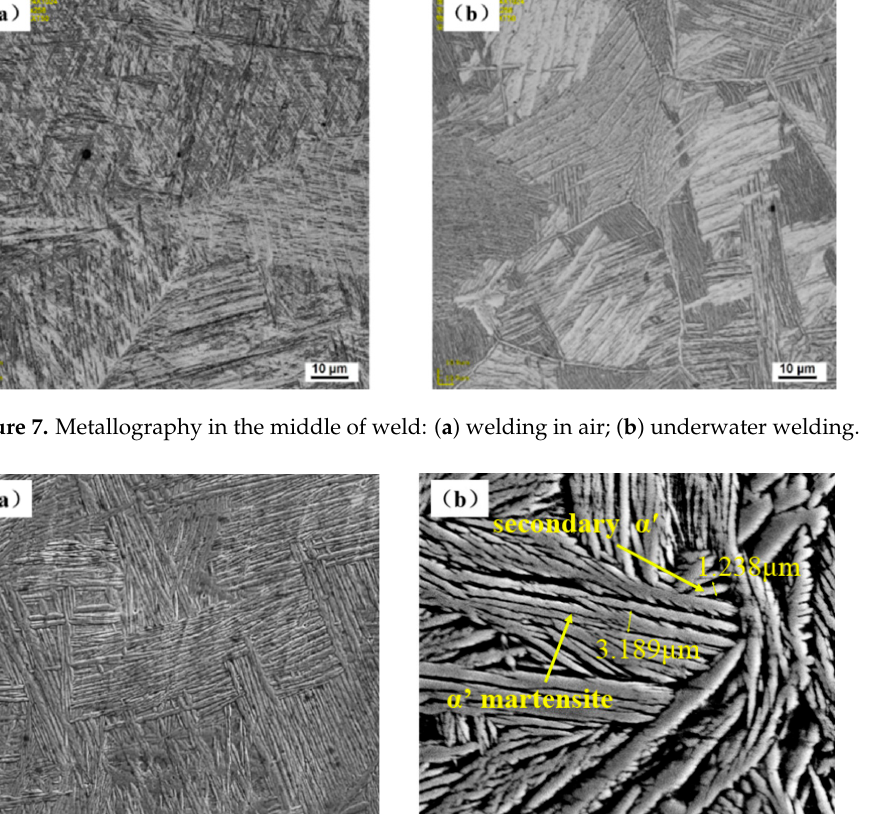
welding are mainly composed of α (cid:48) and β phase. The content of α (cid:48) phase underwater welding is obviously higher than that of weld in air. Due to the fast-cooling rate of molten pool in underwater environment, the β phase transformation is reduced at this time, so the weld of underwater welding obtains more of an α (cid:48)